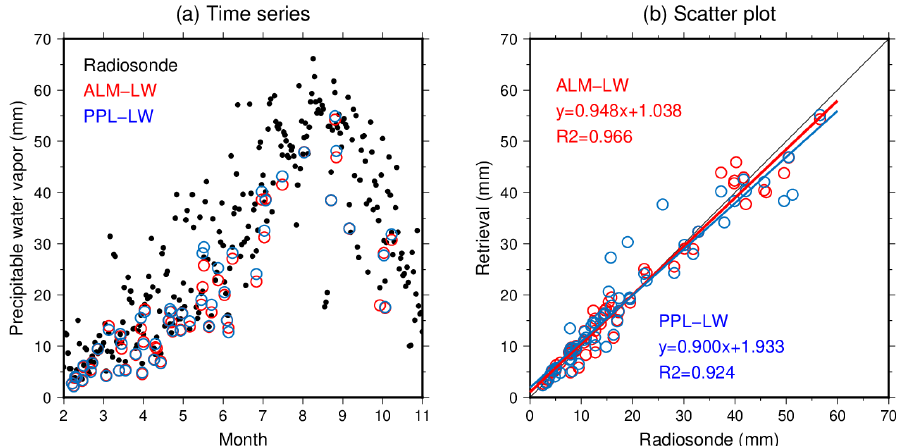
Figure 12. Seasonal changes (a) and scatter plots (b) for the precipitable water vapor of the ALM-LW (red), PPL-LW (blue), and radiosonde observations (black); y = ax + b and R2 are the linear fitting and coefficient of determination.